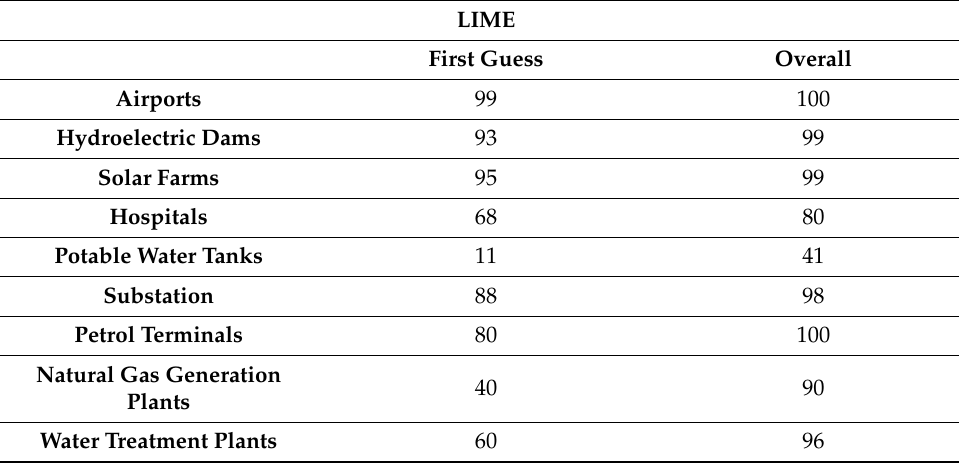
Table 4. LIME results for the nine CI facility